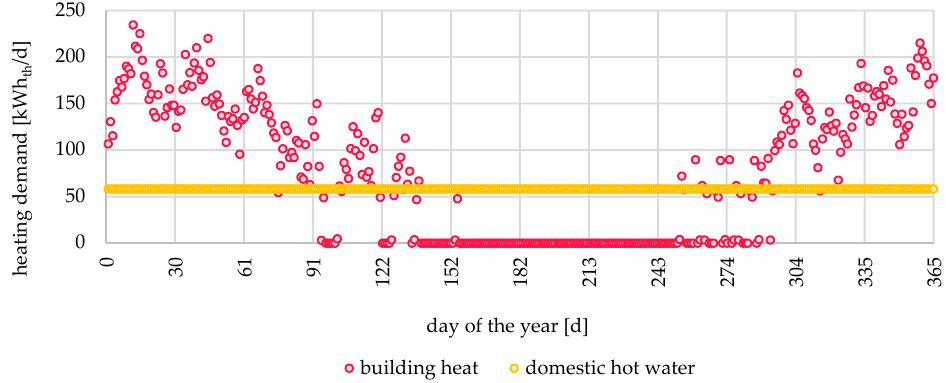
Figure 14. Annual demand profile of the reference multifamily house used in this work.